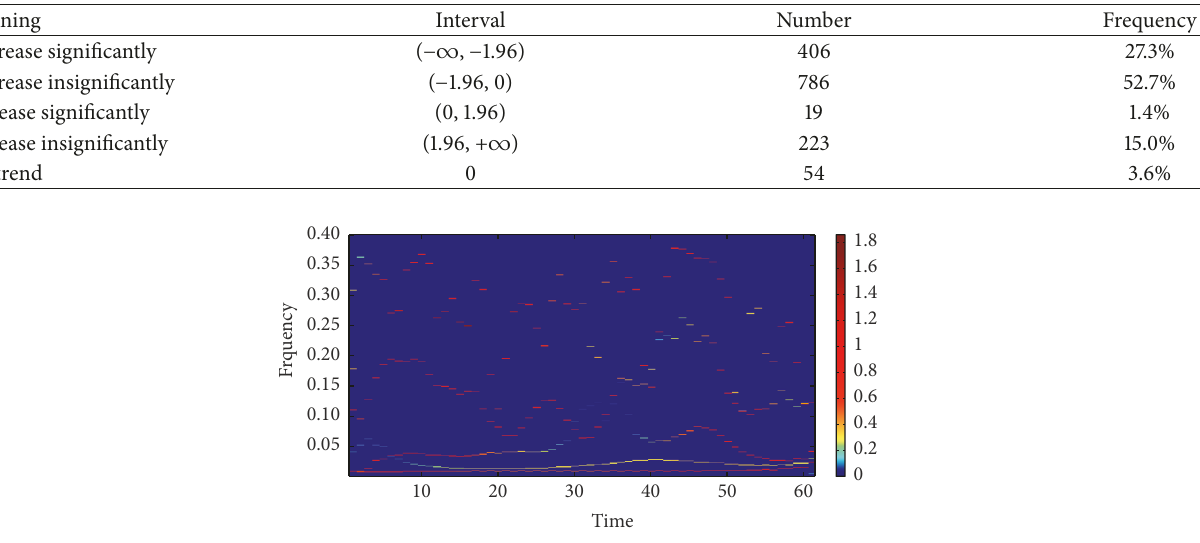
Figure 4: Hilbert spectrum.